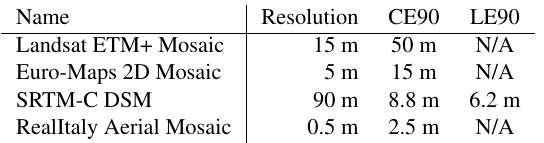
Table 1: Reference and check datasets and their horizontal and vertical